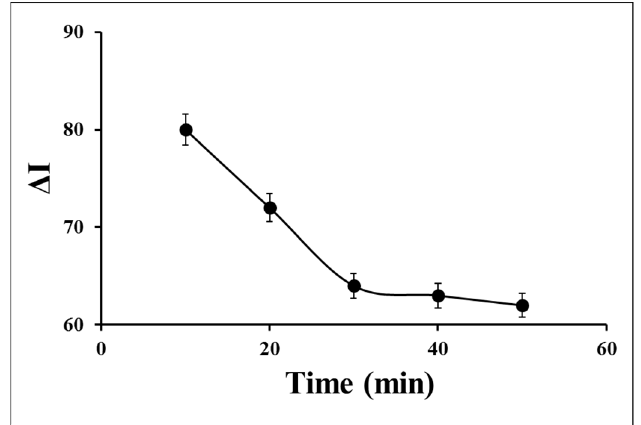
Figure 4. Effect of incubation time of S. aureus on the aptasensor signal for 1.5 × 10 6 CFU mL (cid:2879)(cid:2869) of S. aureus in 0.1 M PBS containing 0.1 M KCl and 1 mM ferro/ferricyanide (cid:4666)(cid:4670)Fe(cid:4666)CN(cid:4667) (cid:2874) (cid:4671) (cid:2871)(cid:2879) (cid:2872)(cid:2879)⁄ (cid:4667) as a redox marker.